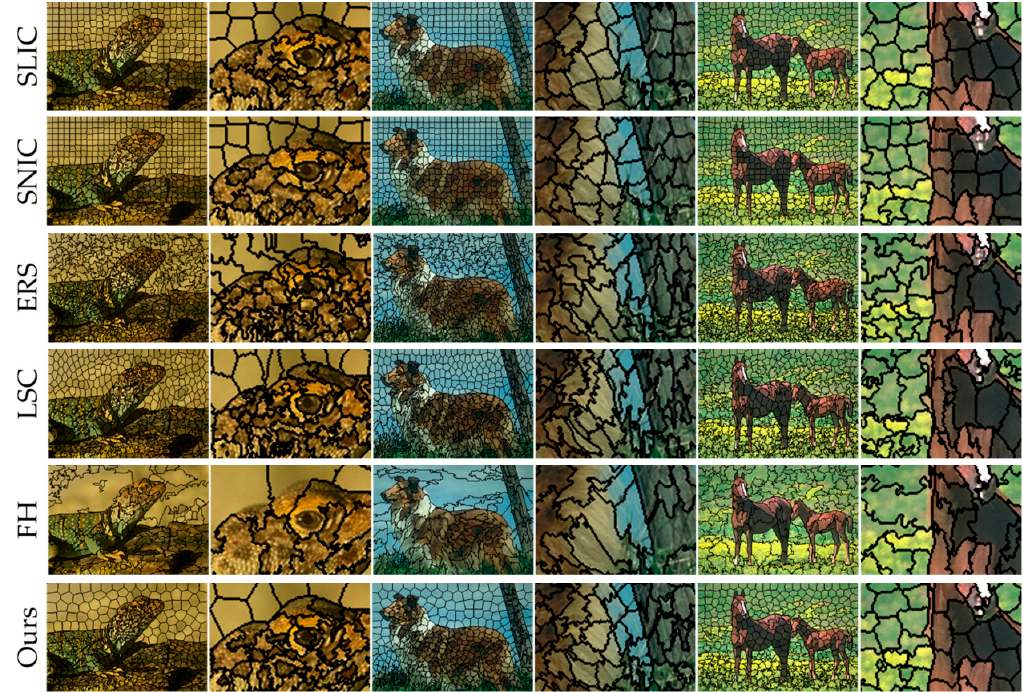
Figure 9. Visual comparison of superpixel segmentation results using different algorithms.